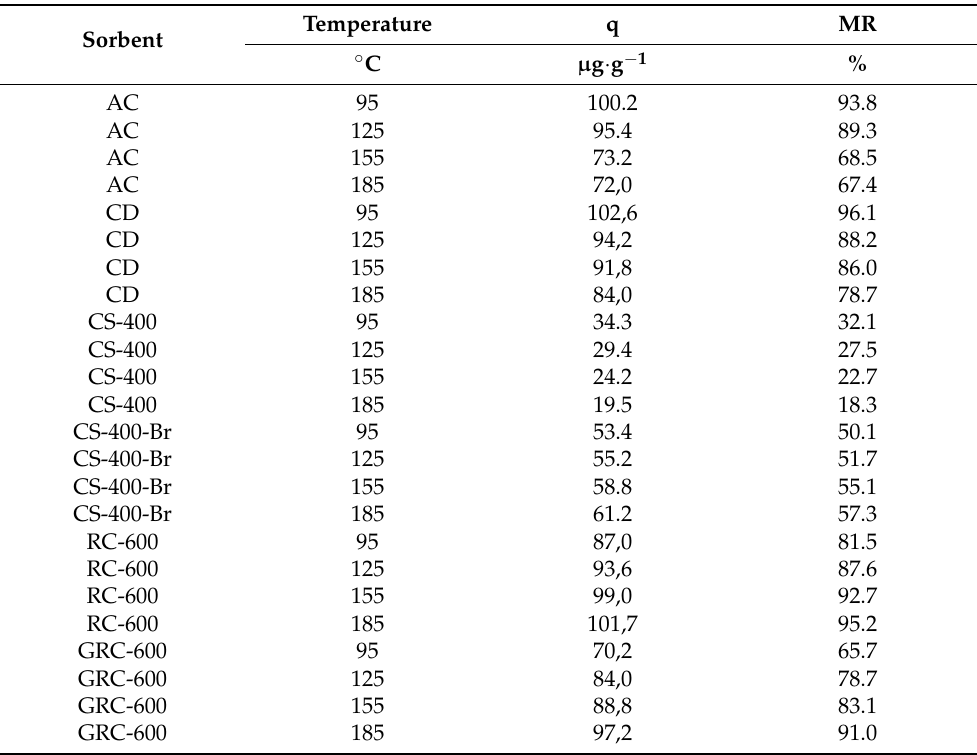
Table 7. Efficacy assessment of LCOA for Hg sorption at different